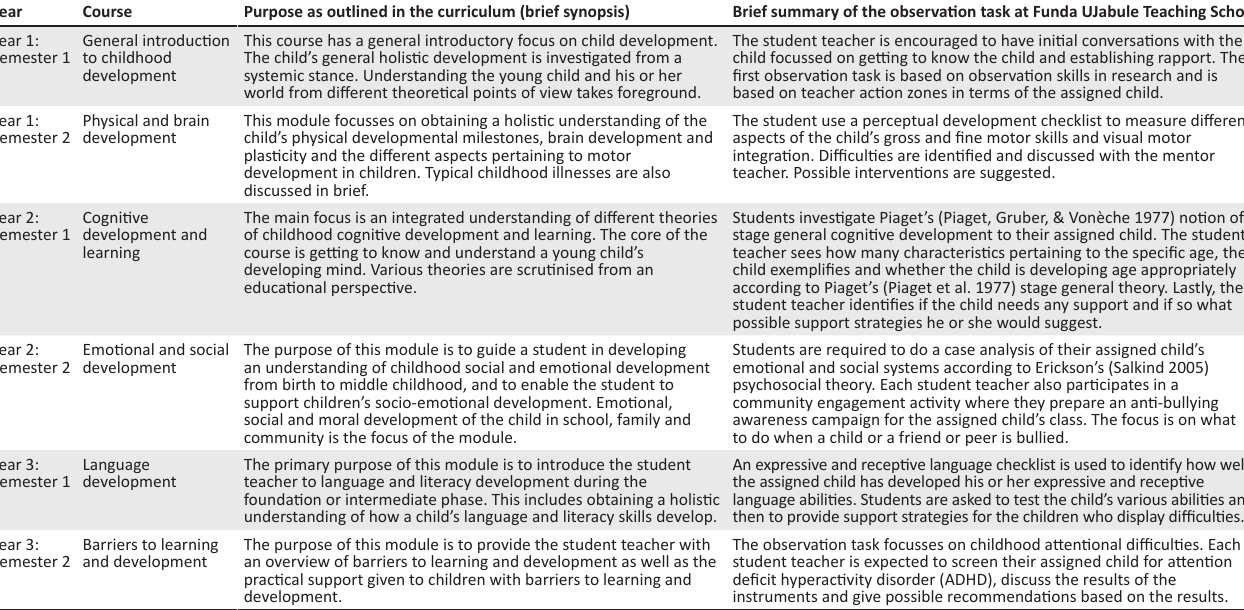
TABLE 1: The main focus and tasks in the child development